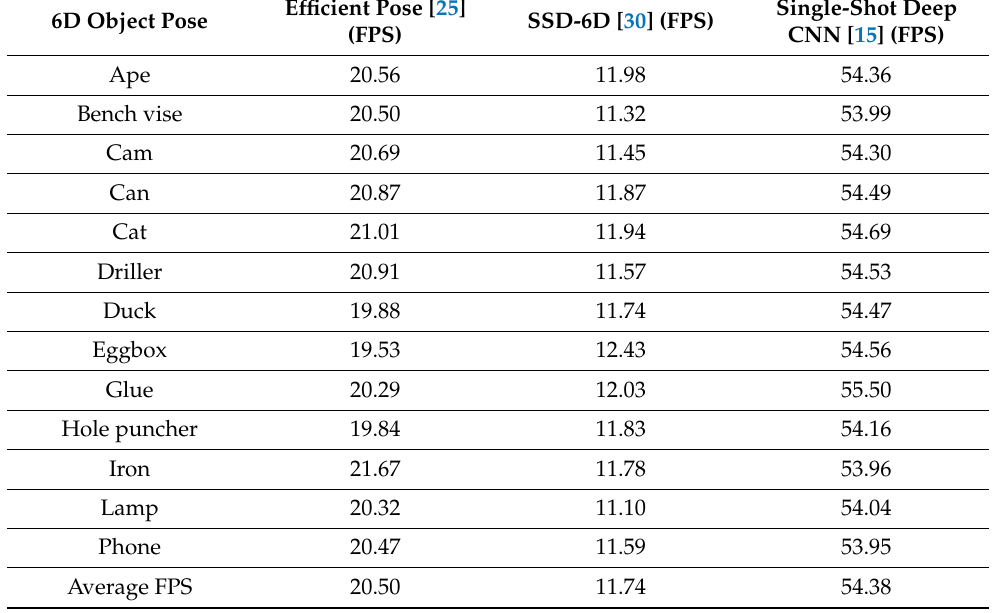
Table 1. Runtime performance comparison between single object pose estimation algorithms. LineMOD dataset is